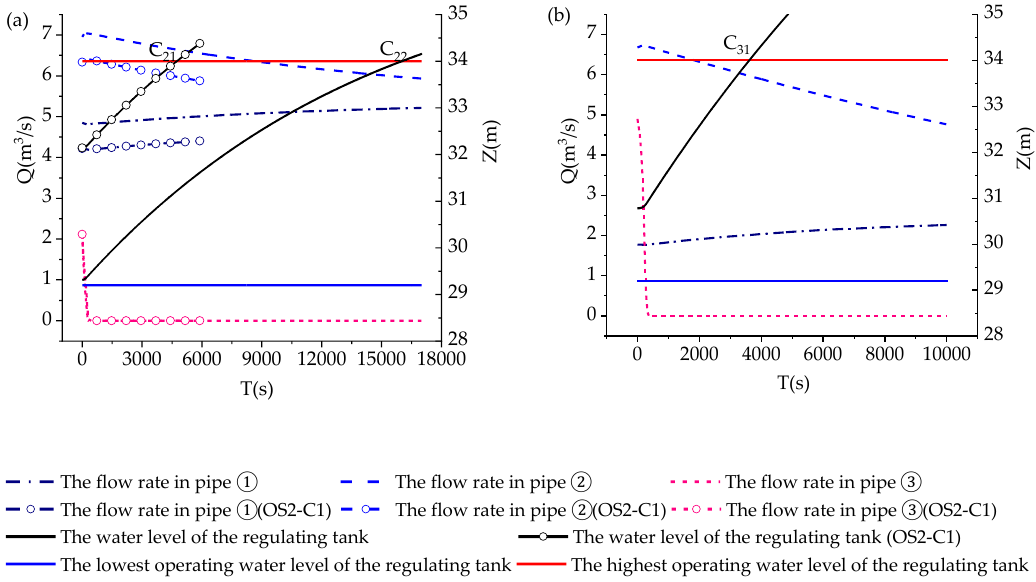
Figure 7. ( a , b ) Transient processes of scenario OS2 and OS3 under